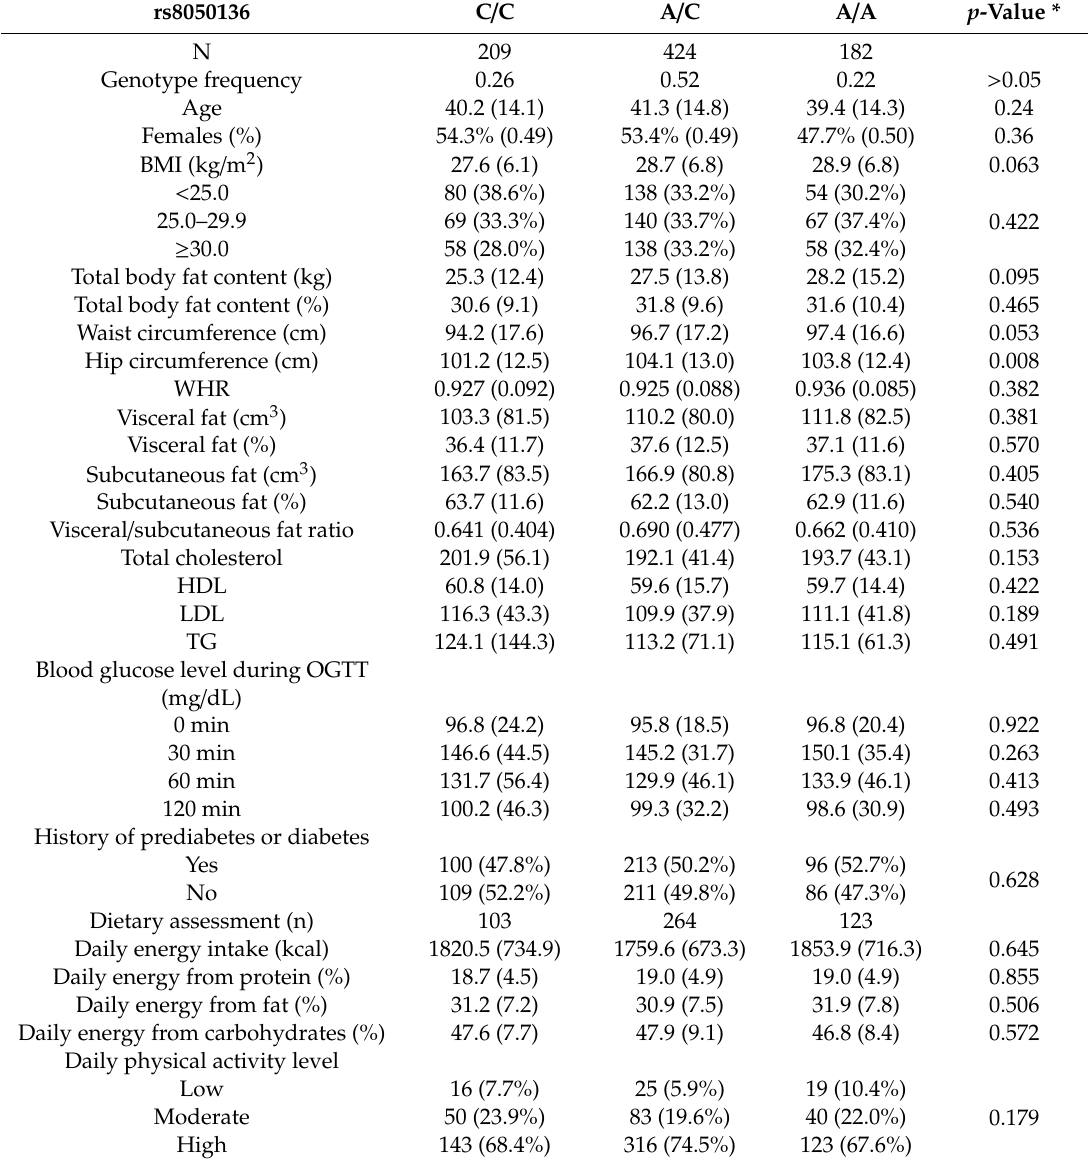
Table 3. Characteristics of participants stratified by rs8050136